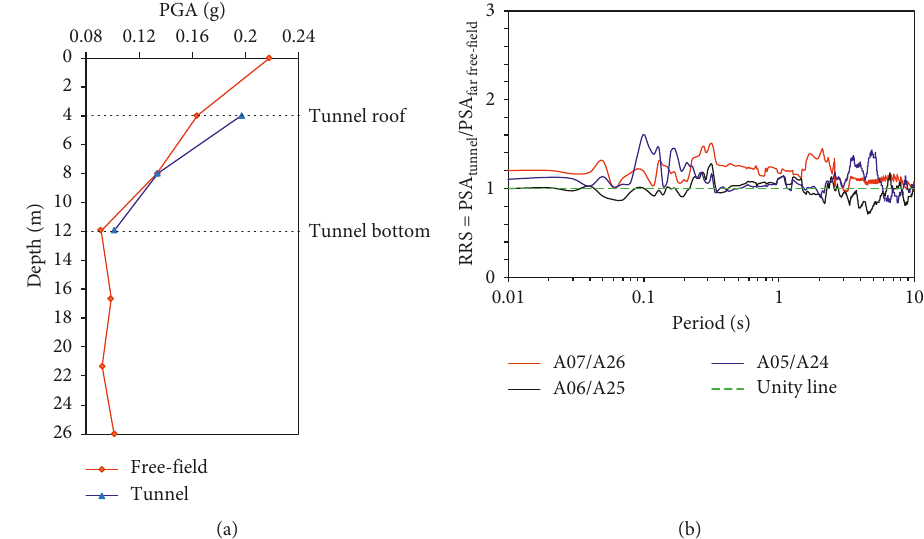
Figure 10: Evidence of the influence of F on tunnel response from the centrifuge test. (a) PGA profiles at free-field and tunnel wall. (b) RRS of the tunnel and free-field responses (A07 � tunnel roof; A06 � tunnel spring line, A05 � tunnel floor; A26, A25, A24 � free-field responses at corresponding depths). Table 3: Study matrix representing the properties of tunnel structure used in this study. Structure